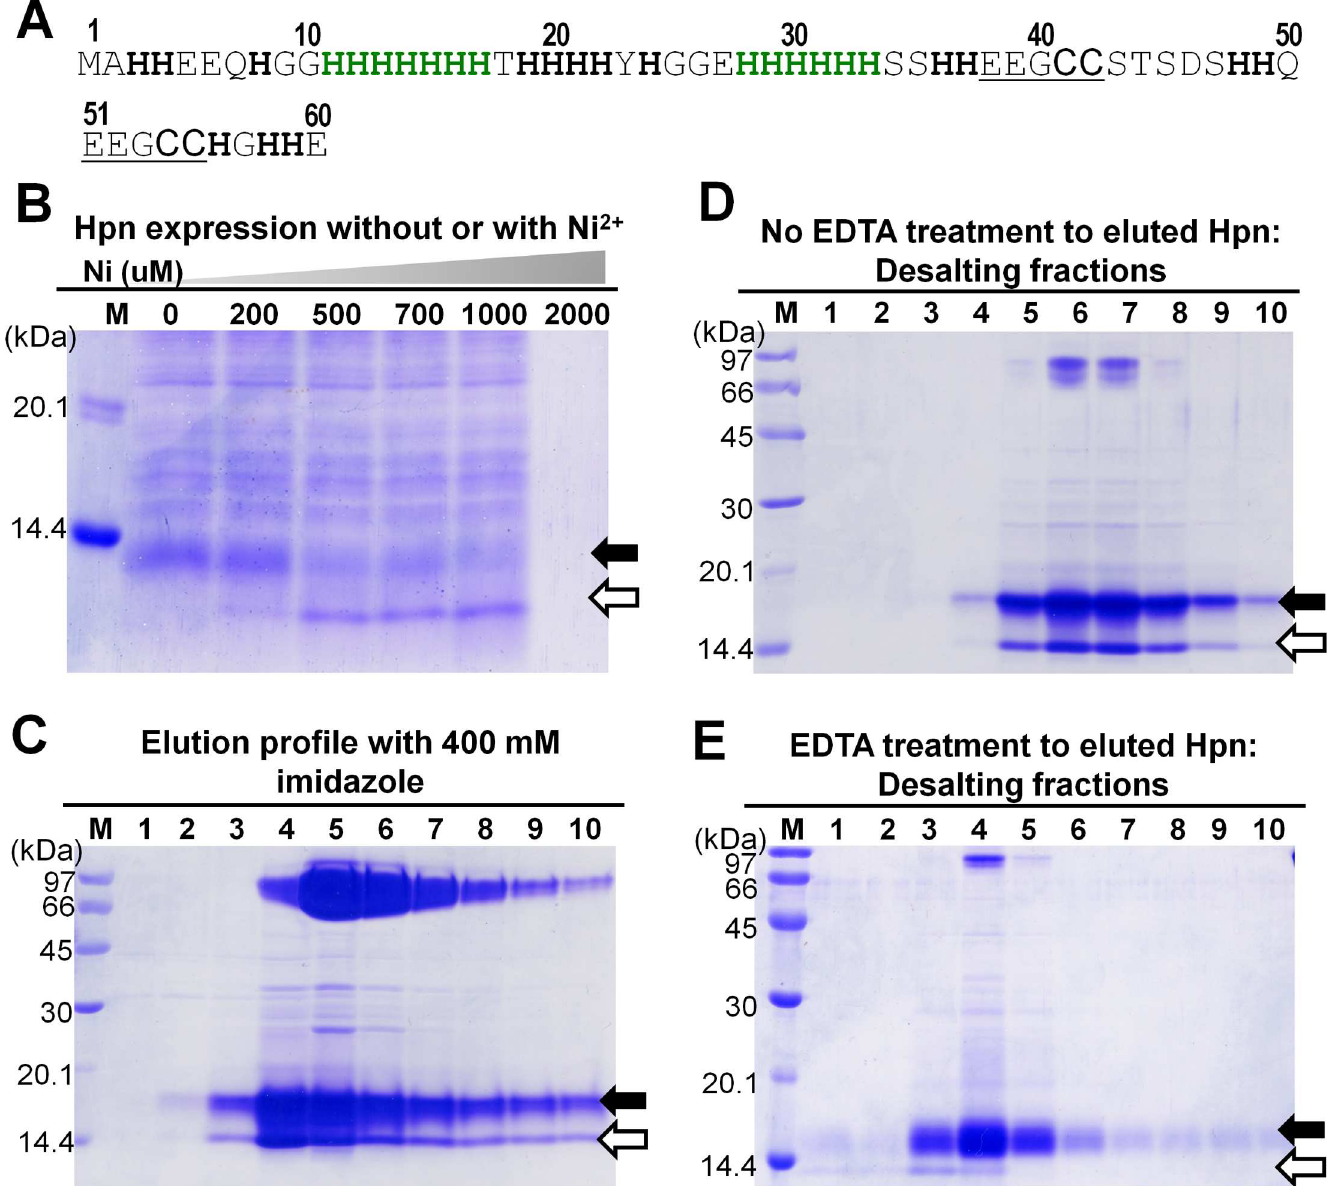
Fig 1. Amino acid sequence, overexpression and purification of recombinant Hpn. LaneM, LMW protein marker standards (GE Healthcare; MW from top to bottom: 97, 66, 45, 30, 20.1 and 14.4 kDa); black arrows depictingapo-Hpnand white arrows showingprobableNi 2+ -boundHpn protein in all panels.A. Amino acid sequenceof Hpn. Histidineresidues are highlightedin bold. Stretches of six and seven histidinesare highlighted in green and pentapetide repeats (EEGCC) are underlined. B. SDS-PAGE of Hpn expressionwith or without Ni 2+ addedin the culture (polyacrylamide-gel20%). Pellets of 60 μ l bacterial cultures were dissolvedin 60 μ l of 1X Laemmlibuffer and boiledfor 3 min at 100˚C. Final volume of 15 μ l loadedin each lane. C, D and E. Elution profile of purifiedHpn checked by loadingprotein fractions on SDS-PAGE (polyacrylamide-gel15%). Lanes 1 to 10, fractions of purifiedprotein eluted with 400 mM imidazole(C). Elution profiles of desalted fractions of Hpn without EDTA treatment (D) and with EDTA-treatment (E) were analyzed. Equal volume of 2X Laemmlibuffer was added to each eluted fraction and then boiledfor 3 min at 100˚C. Total 10 μ l appliedin each lane in C, D and